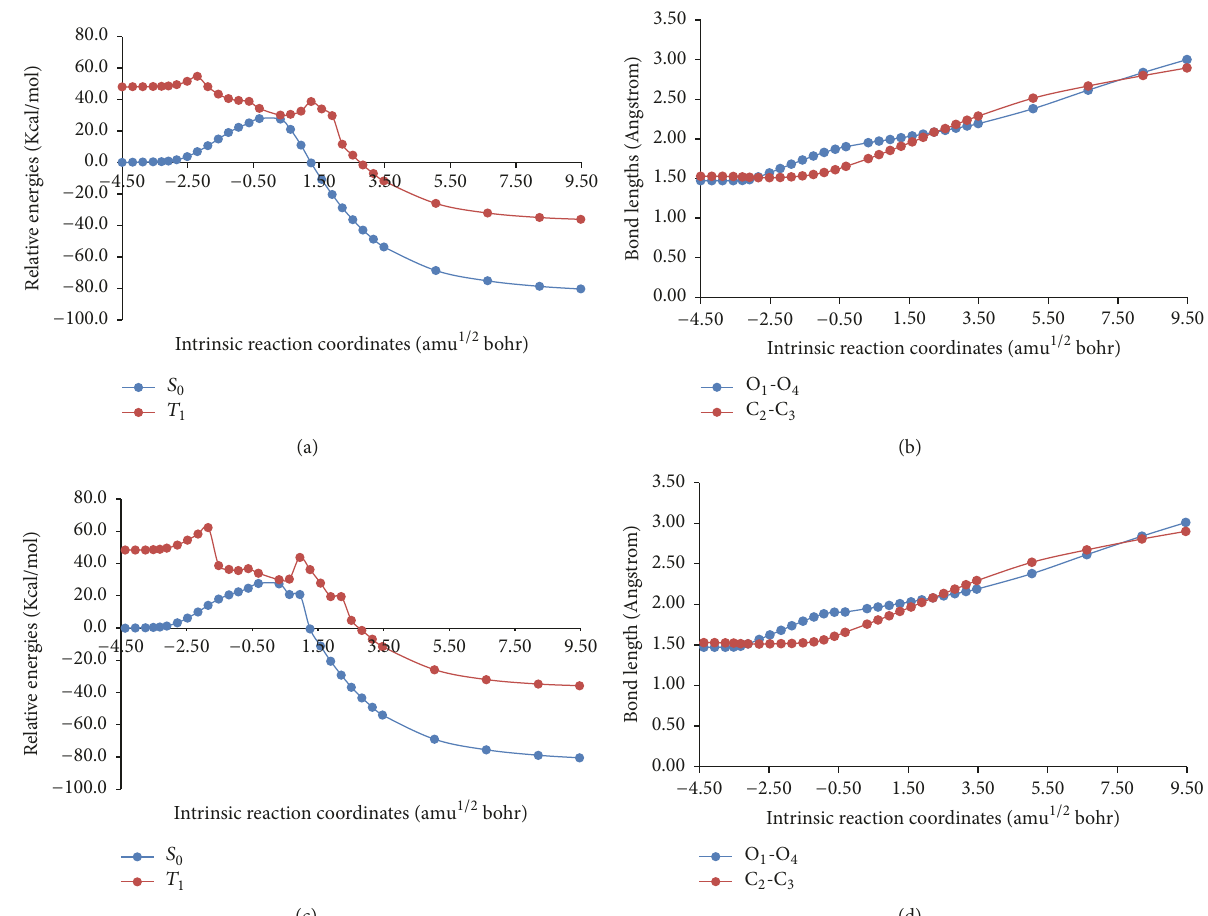
Figure 1: Energy profiles of the 𝑆 0 and 𝑇 1 states, determined in the 𝑆 0 -computed IRC path, for species IVa (a) and IVb (c). O 1 -O 4 and C 2 -C 3 bond length variations recorded during the IRC calculations for IVa (b) and IVb